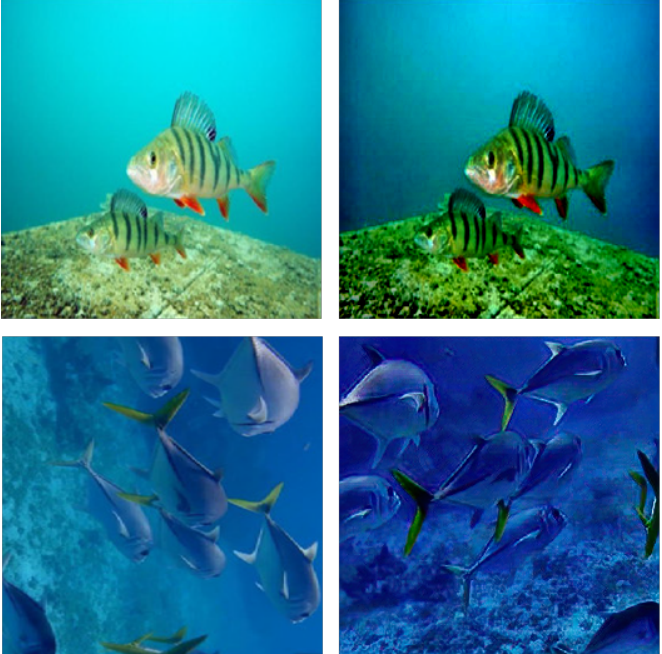
Figure 6. Visual comparison of real underwater images sourced from [46]. From left to right are raw underwater images, and the proposed images. The proposed results are compared with the results from Ancuti [11], dark channel prior (DCP) [4], histogram distribution prior (HP) [36], and Water-Net